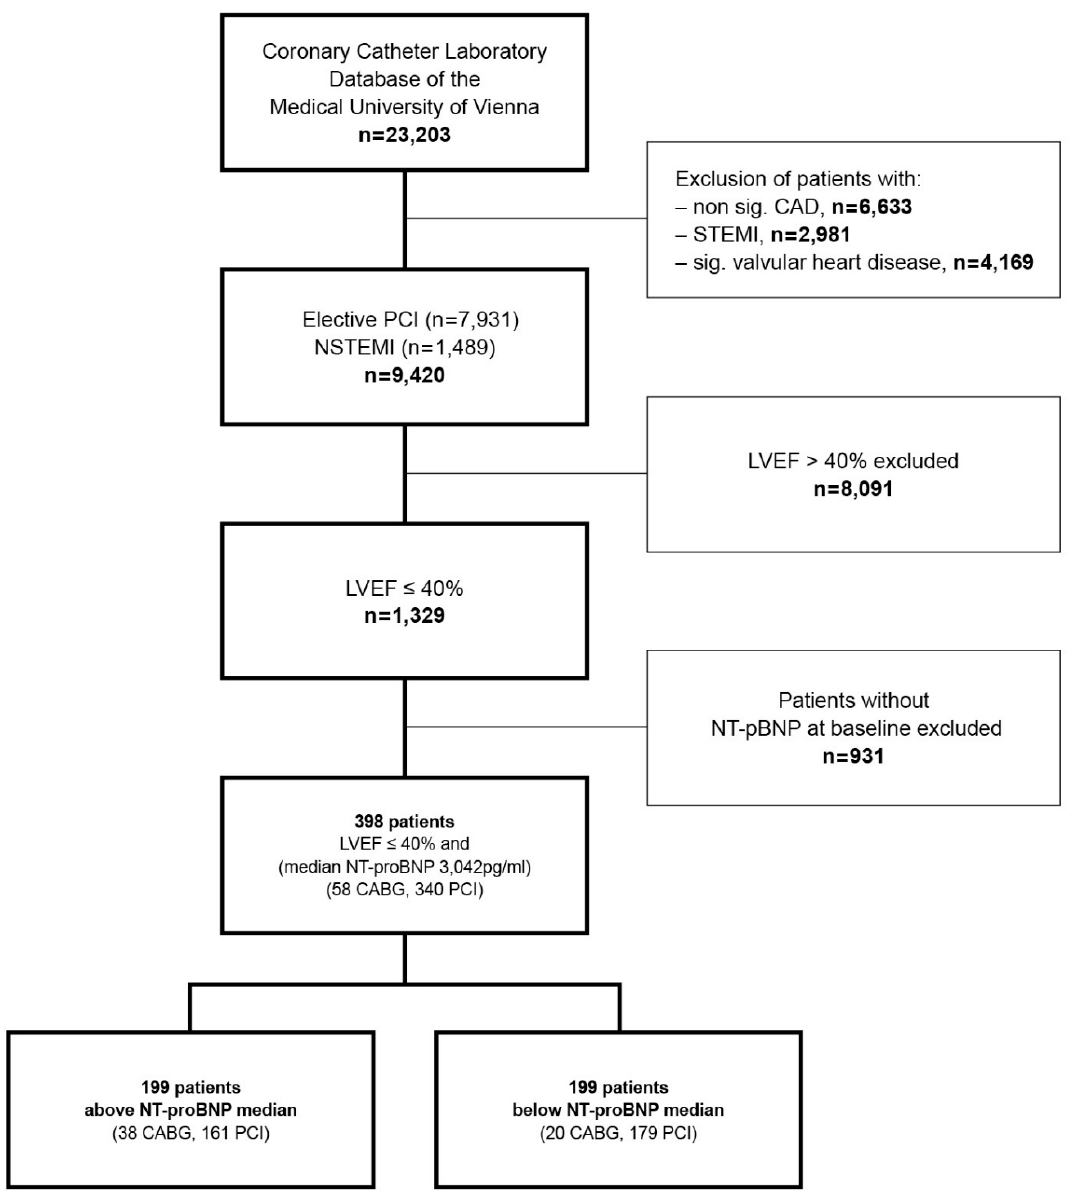
Figure 1. Flow chart. CABG = coronary artery bypass graft, CAD = coronary artery disease, DES = drug eluting stent, LVEF = left ventricle ejection fraction, NSTEMI = non-ST-segment elevation myocardial infarction, NT-proBNP = N-terminal proB-type natriuretic peptide, PCI = percutaneous coronary intervention, STEMI = ST-segment elevation myocardial infarction.